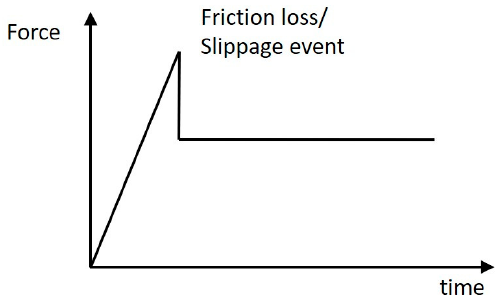
Figure 28. Principle drawing showing a loss of friction/slippage event.